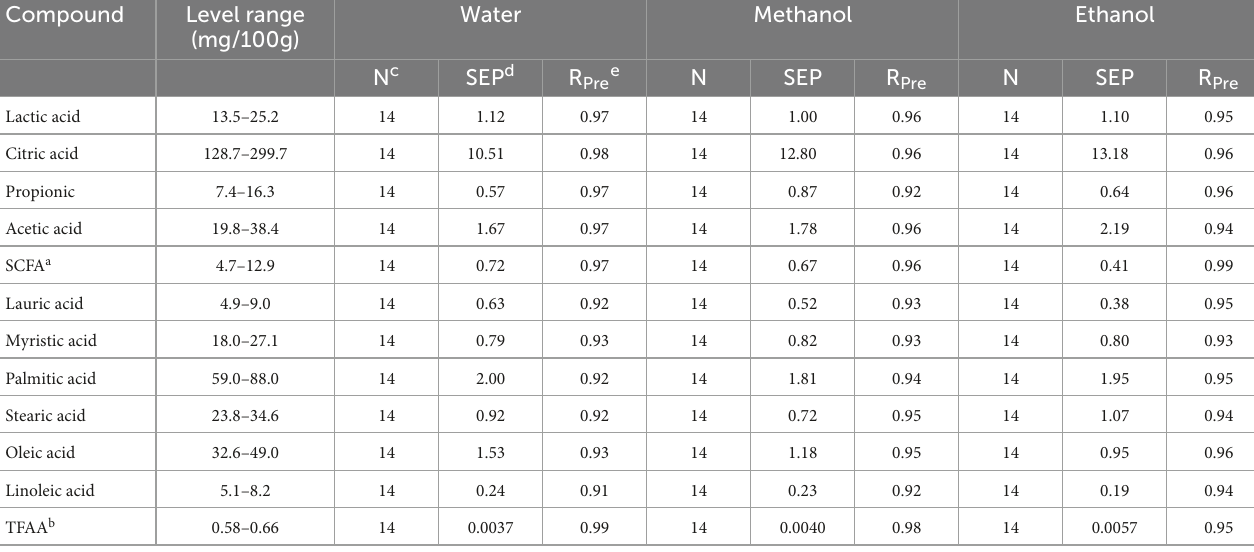
TABLE 4 Performance statistics of the validation models developed using FT-IR, for the prediction of free amino acids, organic acids, and free fatty acids in soluble extracts (water, methanol, and ethanol) samples during the ripening period. Compound Level range